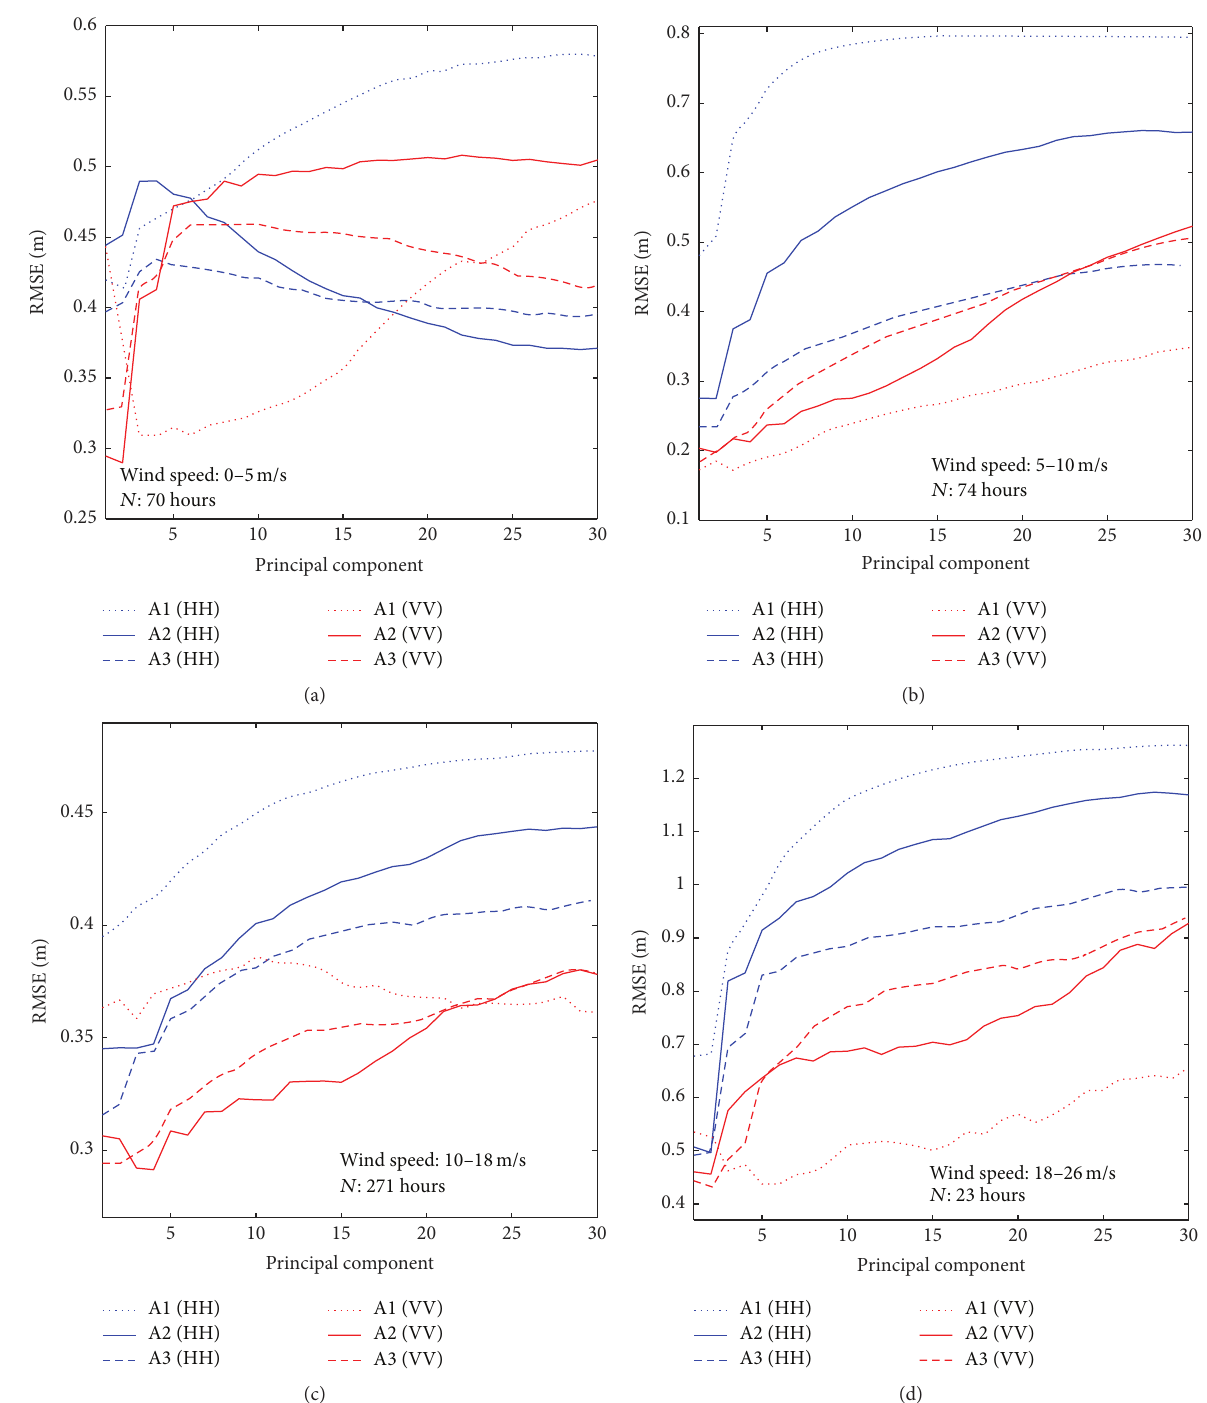
Figure 6: The RMSE between the SWH measured by the buoy and those retrieved from different principal components of X-band marine radars, at the wind speeds of (a) 0–5 m/s, (b) 5–10m/s, (c) 10–18m/s, and (d) 18–26 m/s. The number “ 𝑁 ” at the bottom of each panel denotes the number of hours used in the statistics.